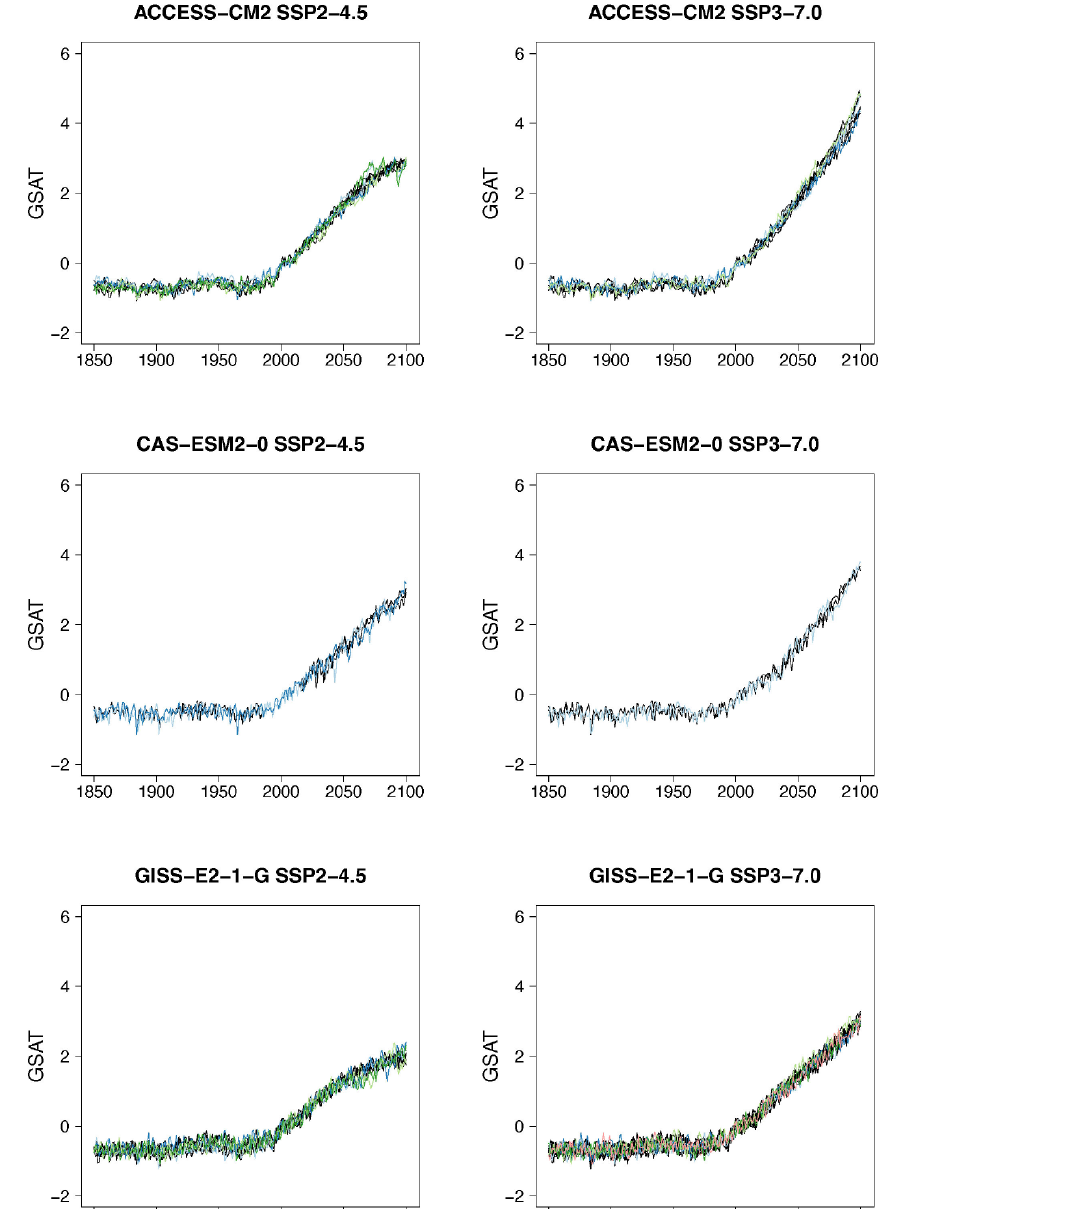
Figure 2. Examples of target (black lines) and stitched (colored) GSAT time series for three ESMs in the PANGEO archive that ran at least one trajectory along the Tier 1 experiments of ScenarioMIP (SSP1-2.6, SSP2-4.5, SSP3-7.0, SSP5-8.5). We choose these three models as they provide differing ensemble sizes (see Table 1) and are characterized by different values of equilibrium climate sensitivity (4.73, 3.40, and 2.72K, respectively). See Figs. B1–B7 for further